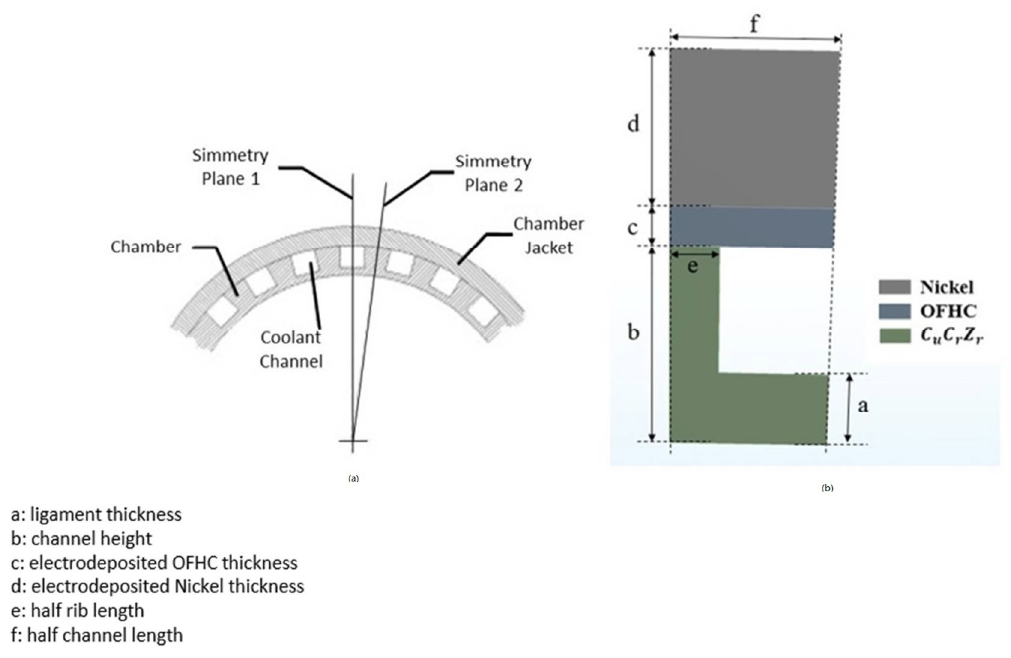
Figure 5. Highlight of symmetry conditions ( a ) and cooling channel section ( b ).